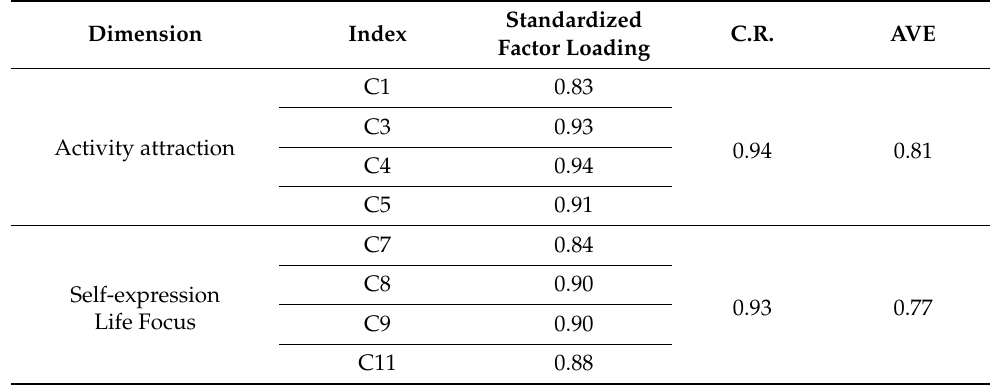
Table 3. Summary of Convergent Validity and Dimension Reliability-Leisure Involvement.